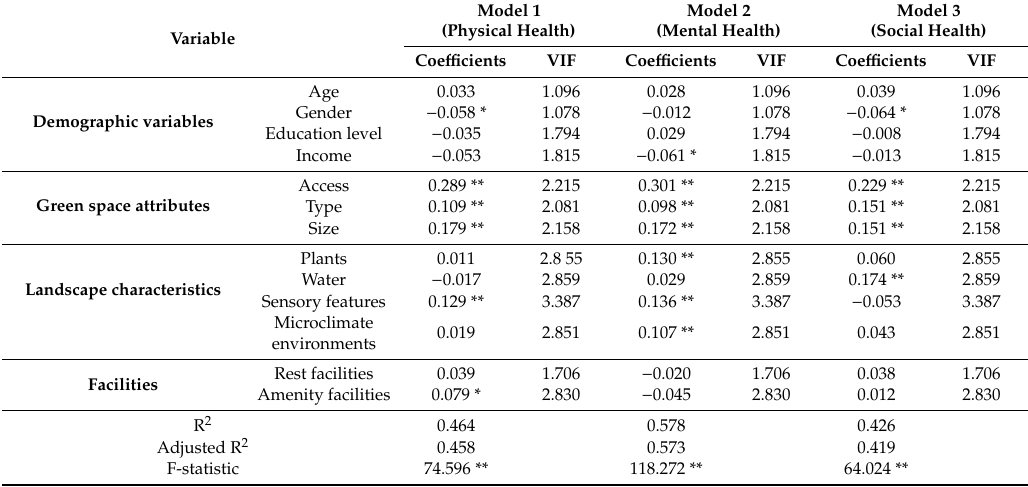
Table 5. Multiple regression results with willingness to use parks to promote health as the dependent